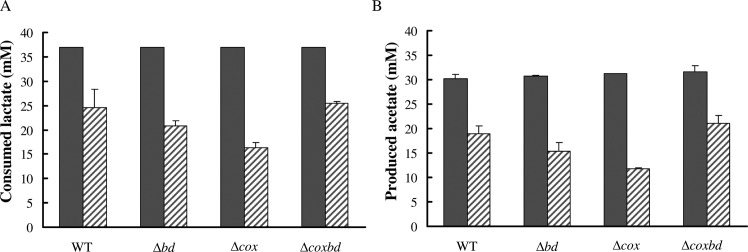
Lactate consumption and acetate production in the DvH strains.Quantification of consumed lactate (A) and produced acetate (B) after 40h growth under anaerobic conditions (black bars) or with constant 0.02% O2 gas mixture sparging (striped bars) in medium C (with 37mM of lactate as initial concentration).